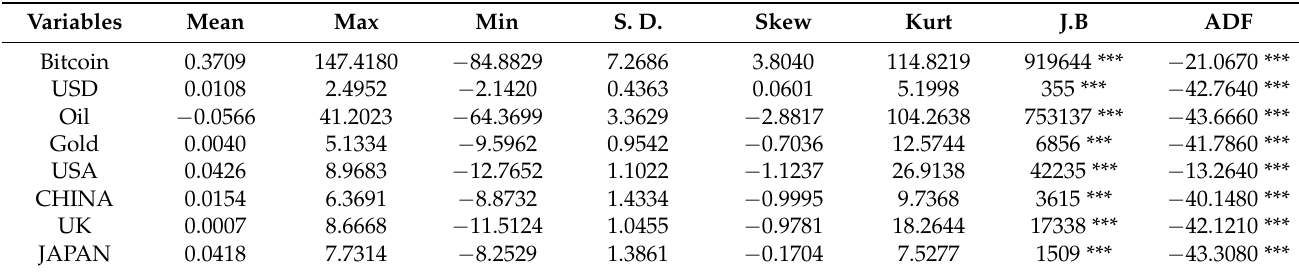
Table 1. Descriptive statistics of the data.